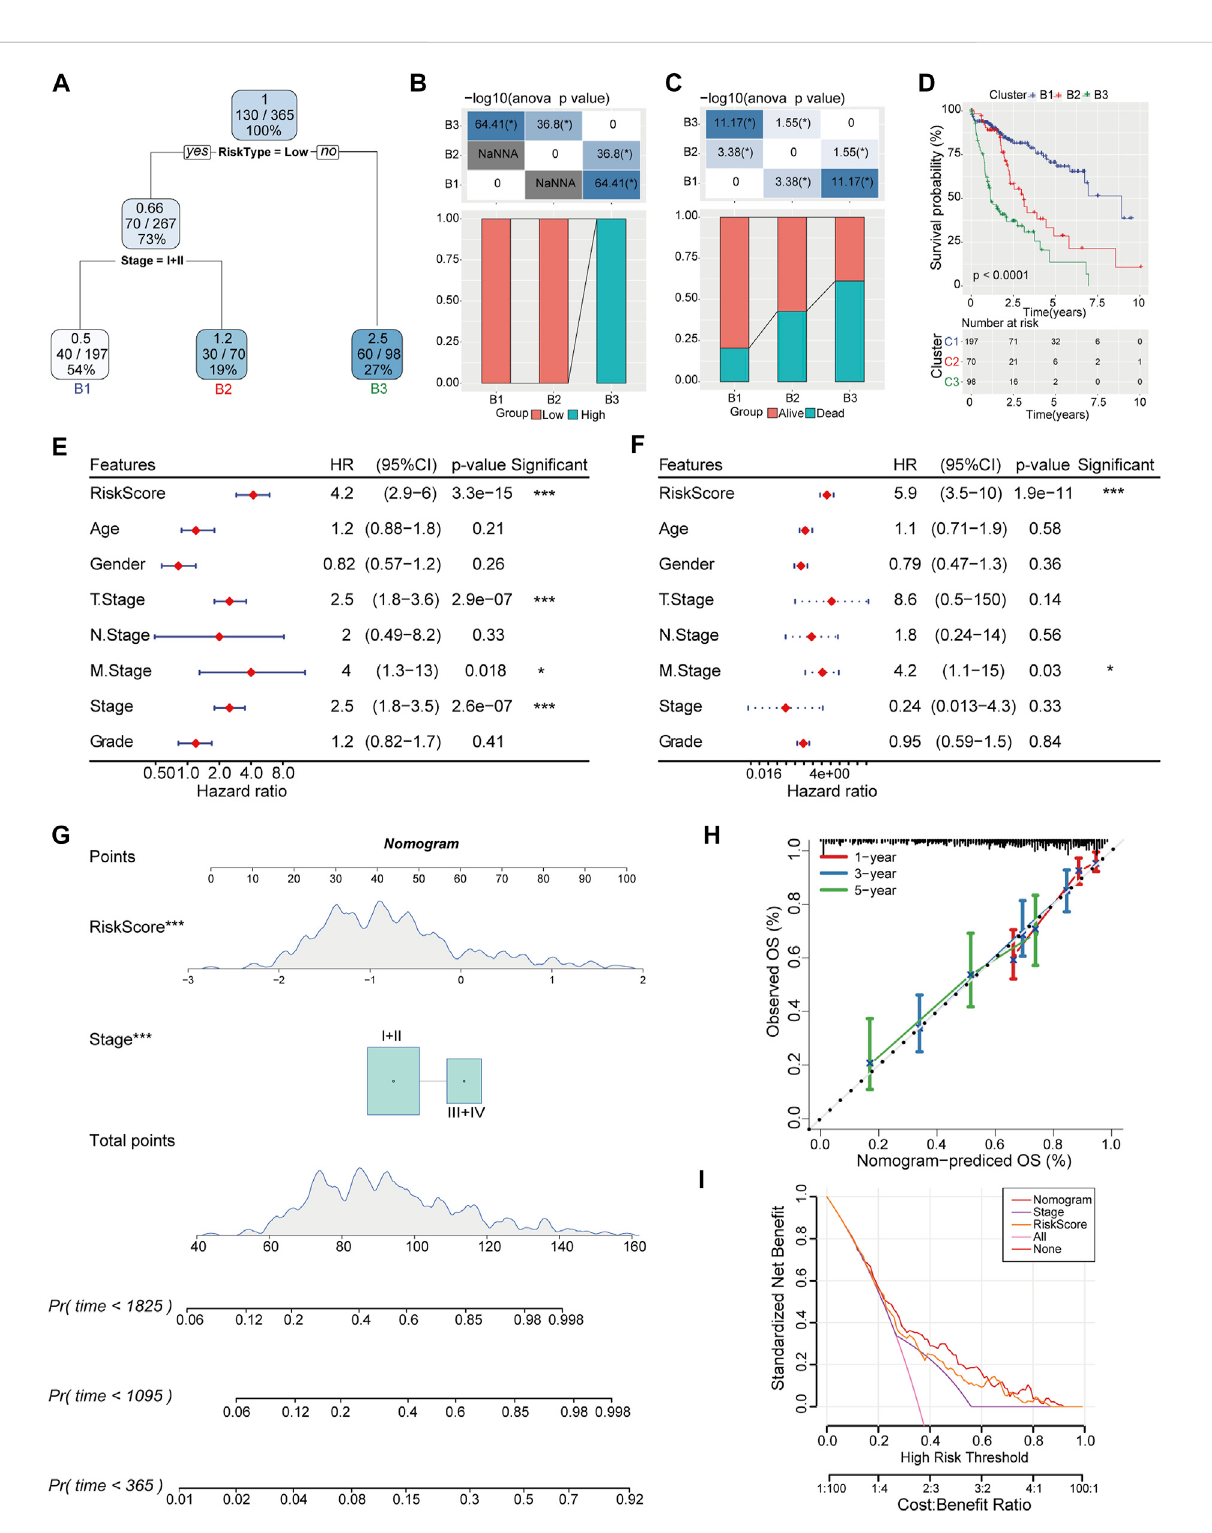
FIGURE 8 Constructionofdecision treeandnomogramcombinedwithriskscoreandclinicalpathologicfeatures. (A) Decisiontreewasconstructedbasedon risk score and TNM stage. (B) The distribution of different risk categories in each branch. (C) Clinical outcomes of patients in two risk groups were estimated in each branch. (D) Differences of overall survival rate in three branches were evaluated by Kaplan-Meier analysis. (E, F) Univariate and Multivariate Cox regression analysis was conducted to determinethe independent risk factor of HCC. (G) Nomogram integrated with risk score and TNMstage. (H) Calibration diagram fornomogrampredicted OSand observed OS in1,3, 5-year. (I) The reliability oftheriskmodelwasevaluated byDCA curves of